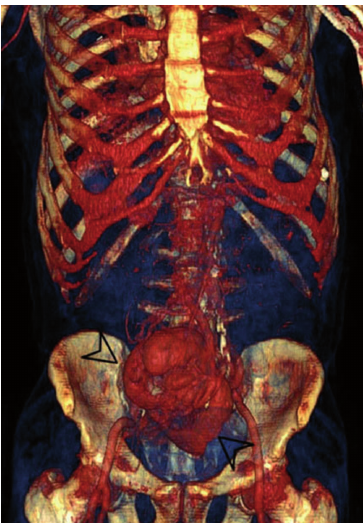
figure 2 - Three dimensional volume rendering image shows pancake kidney